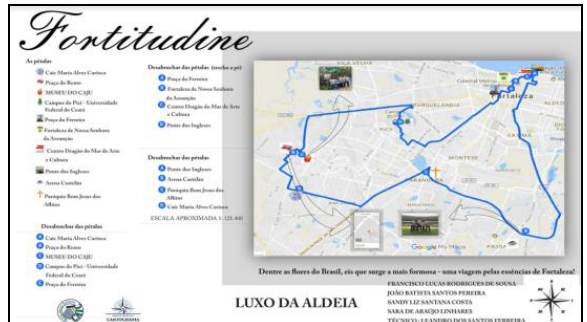
Figure 2.Touristic aspects around the team’s school in Fortaleza city.